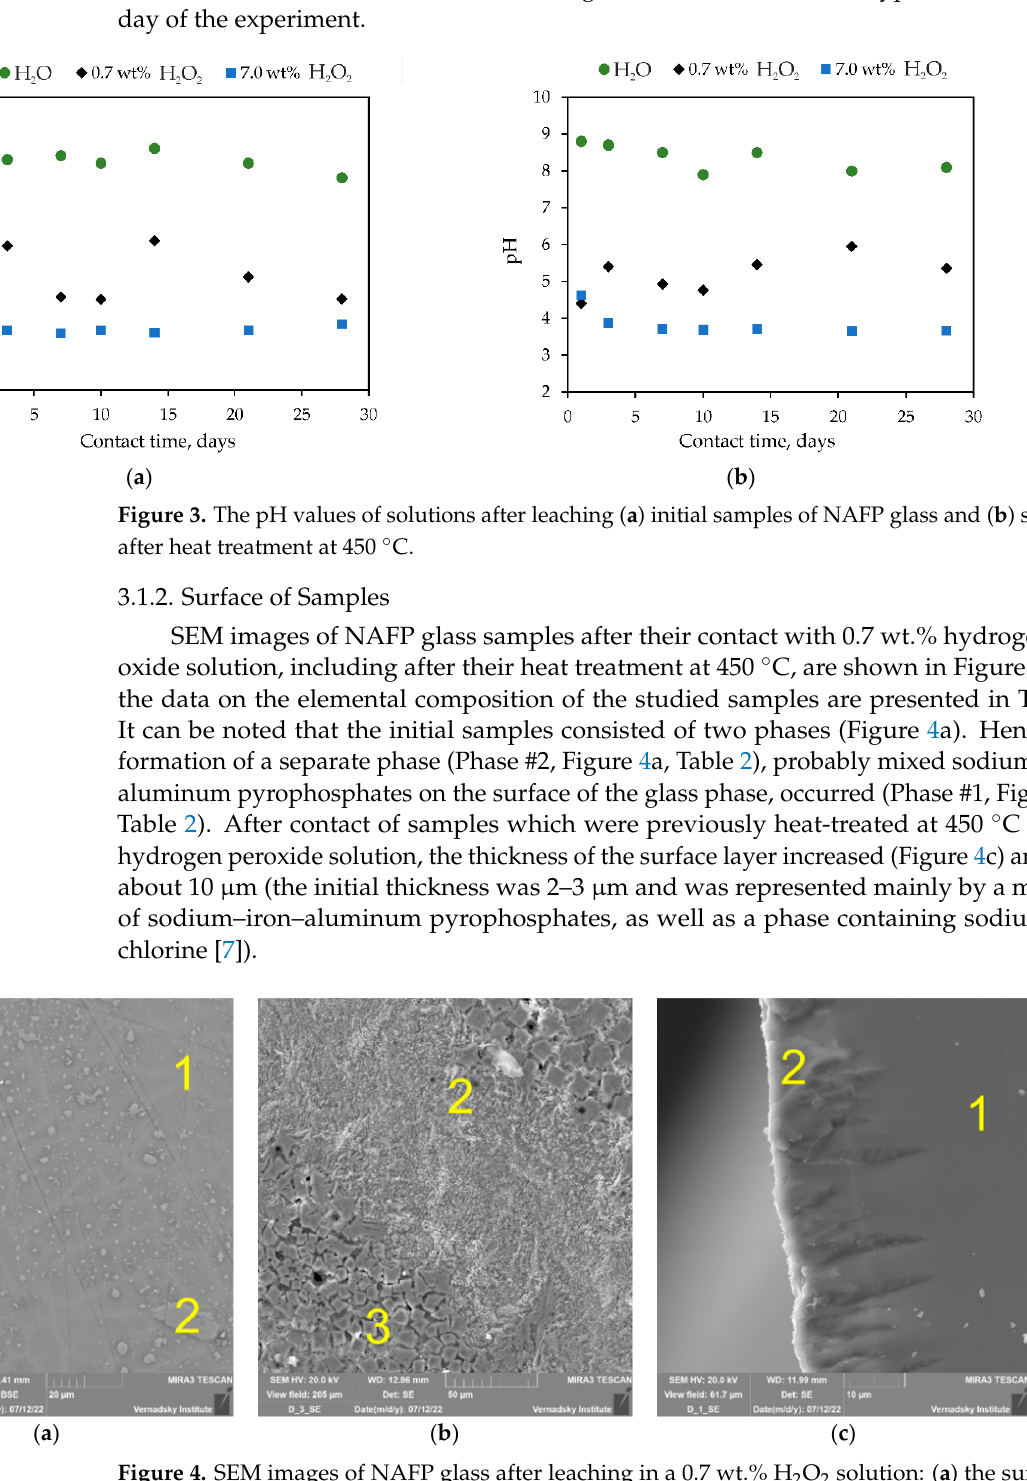
Figure 4. SEM images of NAFP glass after leaching in a 0.7 wt.% H 2 O 2 solution: ( a ) the surface of the initial sample; ( b ) the surface of the sample after heat treatment at 450 ◦ C; ( c ) the surface layer boundary of the heat-treated